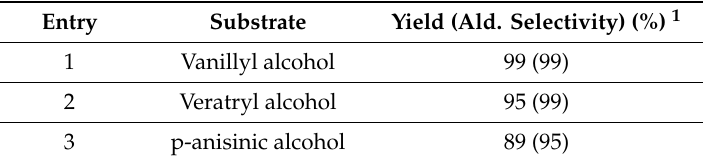
Table 3. Oxidation of other lignin substrate models.